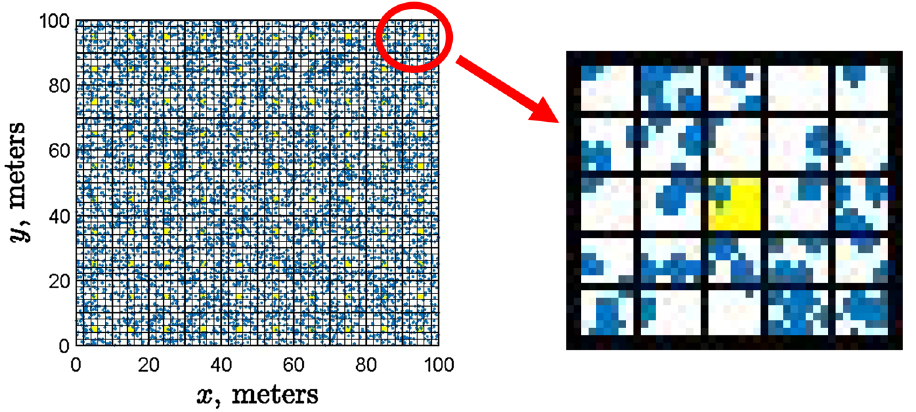
10 grid is additionally split into 25 cells, the central cell Figure 8. Simulating trap counts. Each bin in the 10 × (highlighted in yellow) being regarded as the trap’s catchment area. As an example, the right-hand side of the figure shows the magnified structure of the top-right bin of the study domain. Blue dots show the position of individual animals. The number of animals in the central cell is used as a proxy for the trap